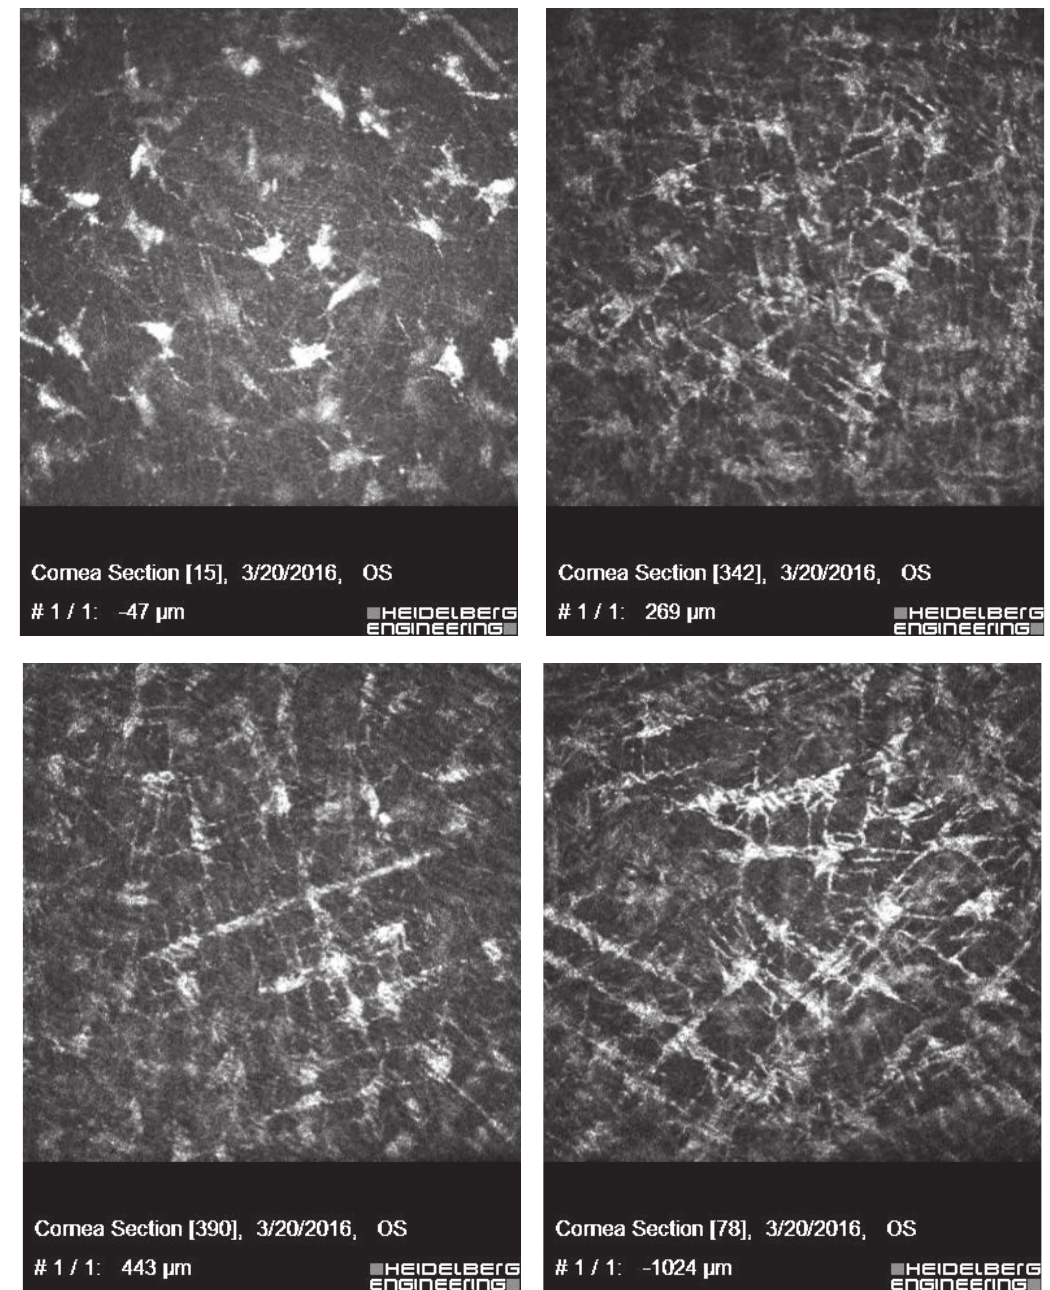
Figure 2. Corneal confocal images of groups sham (a), ozone (b), cross-linking (c), ozone-cross-linking (d), respectively. The keratocytes in stromal level shows straight extensions, which are signs of activity in all groups except control, which are exaggerated in ZX